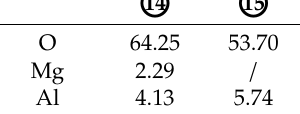
Figure 8. SEM images of the MBG after the heat-treatment. ( a ) 890 °C; ( b ) 1100 °C; ( c ) 1150 °C; ( d ) 1190 °C. Table 9. Chemical compositions of the crystalline phase in the MBG.